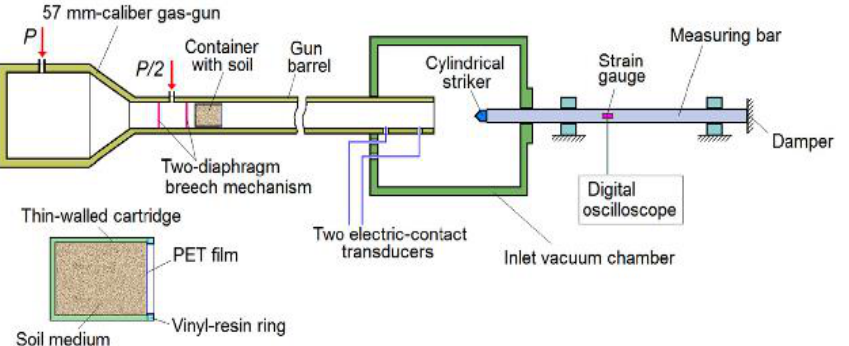
Figure 5. Schematic system for the experimental measurement of the forces resisting the penetration process in the reverse test (reprinted from Ref. [72]).